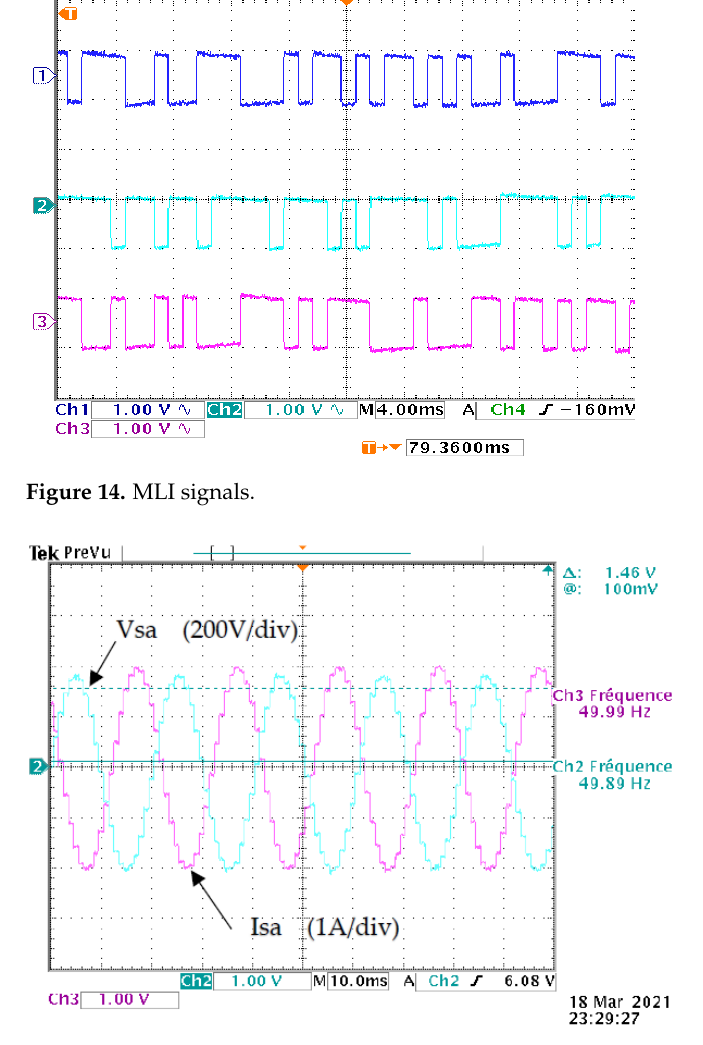
Figure 15. Voltage and current of a phase.